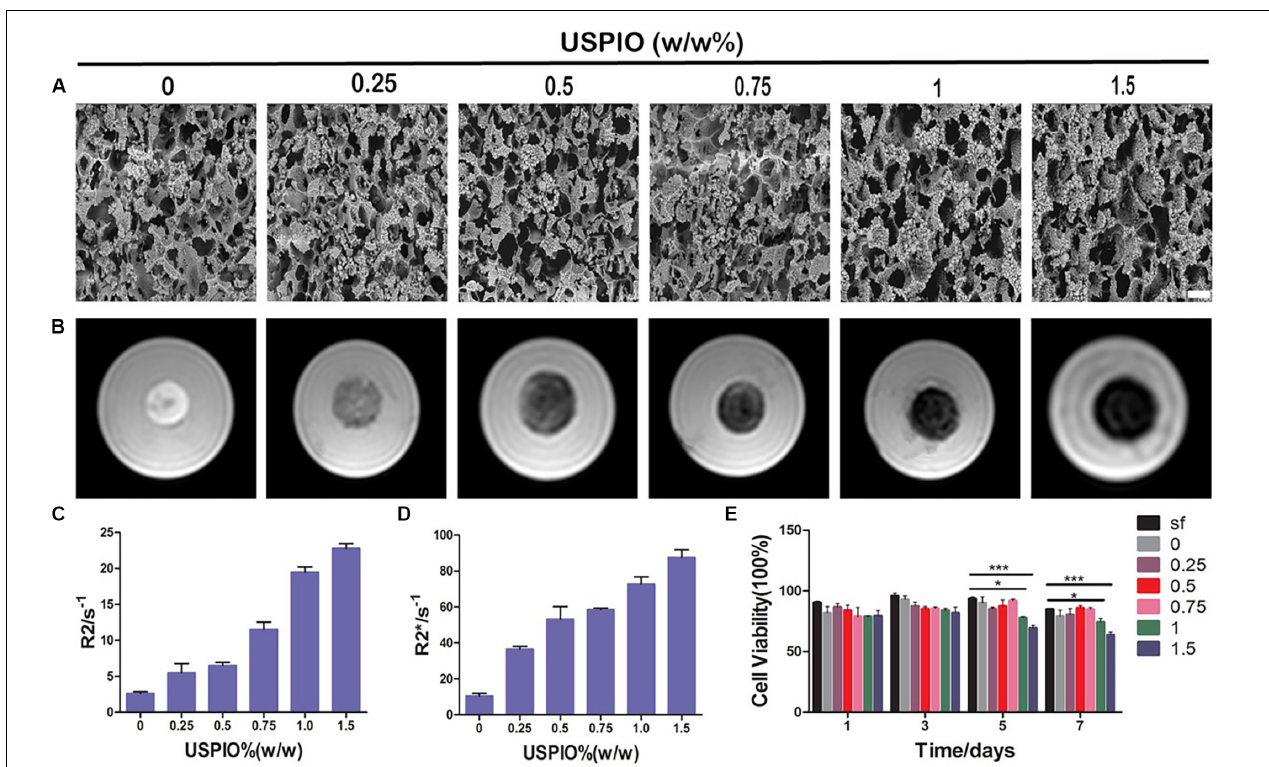
FIGURE 3 | SEM, MRI analysis and cytotoxicity of scaffolds with increasing incorporated amounts of USPIO. (A) SEM images show structural properties of scaffolds with incorporation of USPIO nanoparticles. Scale bar indicates 50 µ m. (B) T2 weighted images demonstrate that the MR signal intensity of USPIO-labeled scaffolds decreased according to USPIO amounts. (C,D) Quantitative R2- and R2*-relaxometry analysis. (E) CCK-8 results show high cell viability of BMSCs ( n = 3, * P < 0.05, ** P < 0.01, or *** P <